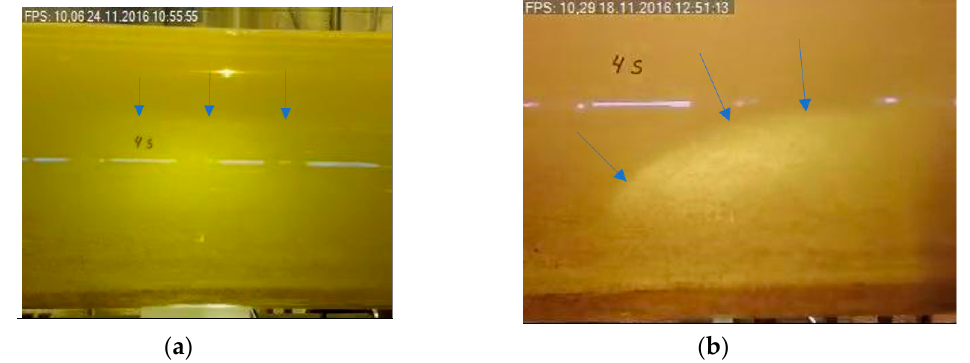
22 of 26 Figure 17. Effect of inner pipe rotation on displacement in inclined wellbore (60 degrees from vertical) with eccentric annulus (e = − 0.42). Curves showing fraction of displacing fluid at station C (near inlet